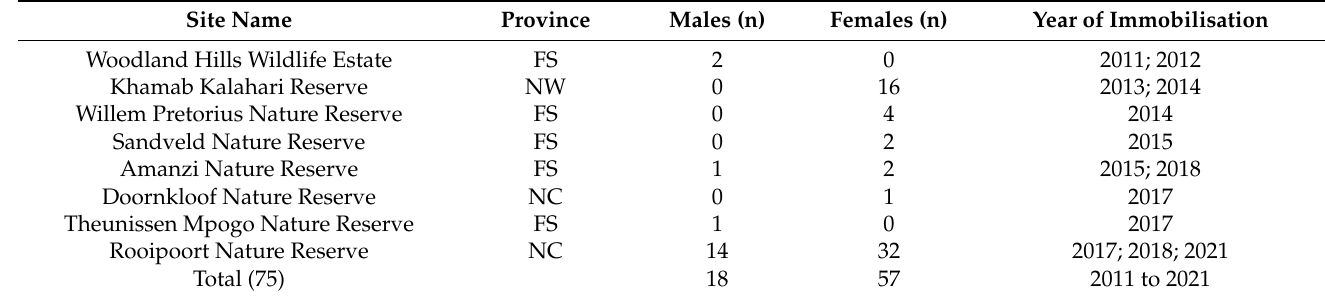
Table 1. The sites, located in the Free State (FS), North West (NW) and Northern Cape (NC), at which, giraffes (n) were captured and immobilised from 2011 to